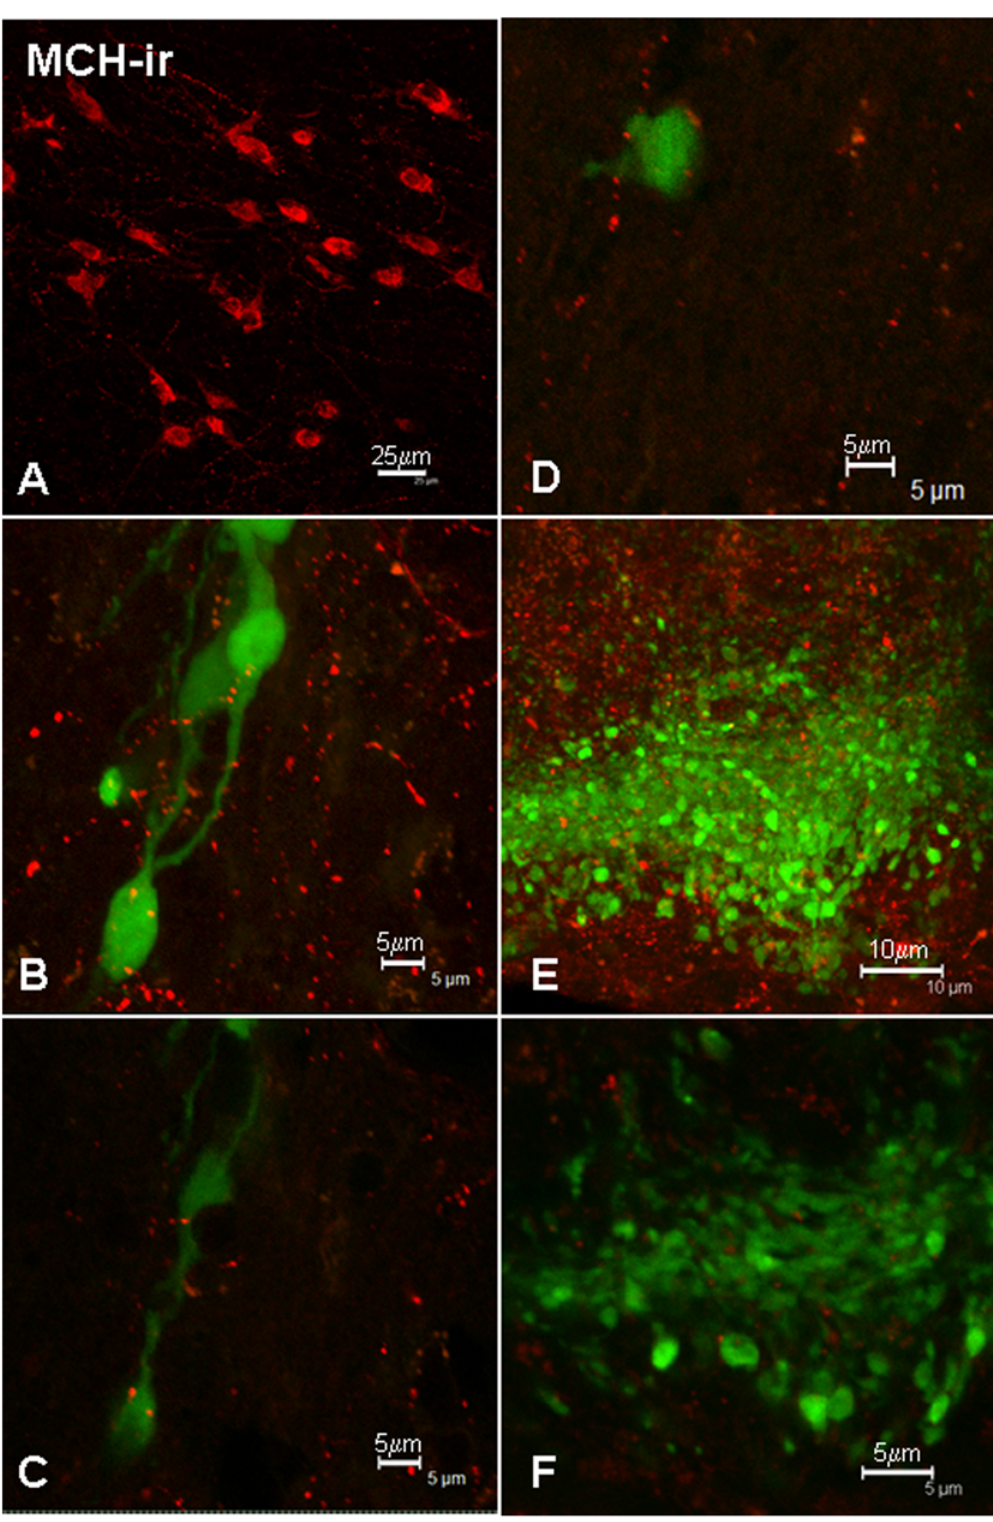
Figure 5. A : MCH-ir perikarya localized in the lateral hypothalamic area (A). Examples of close appositions between MCH-ir fibers (red) and GnRH-GFP perikarya and processes (green) in a maximum intensity projection of the image stack ( B ) and in single 0.5 m m optical slices ( C, D ). MCH -ir fibers and GnRH-ir terminals were observed in proximity in the median eminence ( E ), where the presence of close appositions was confirmed by analysis of single 0.5 m m optical slices ( F ). Scale bars=25 m m ( A ), 5 m m ( B – D ), 10 m m ( E ), 5 m m ( F ).